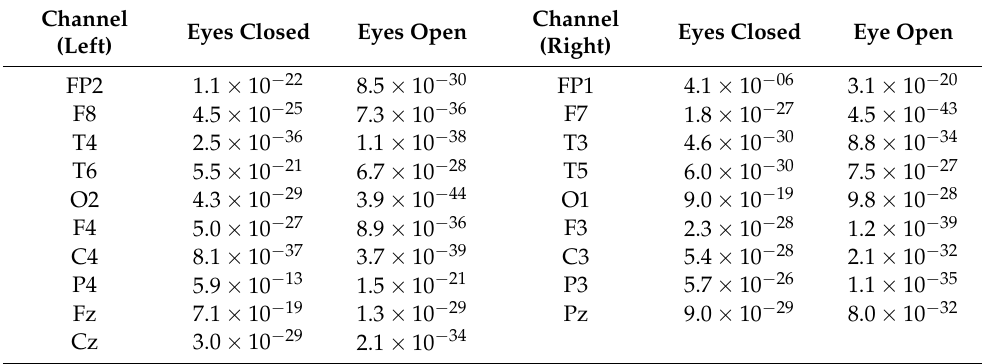
Table 1. The Wilcoxon test results for eyes-closed and eyes-open statuses between depressed and healthy subjects at graph degree 2 ( p values). Channel Eyes Closed (Left)